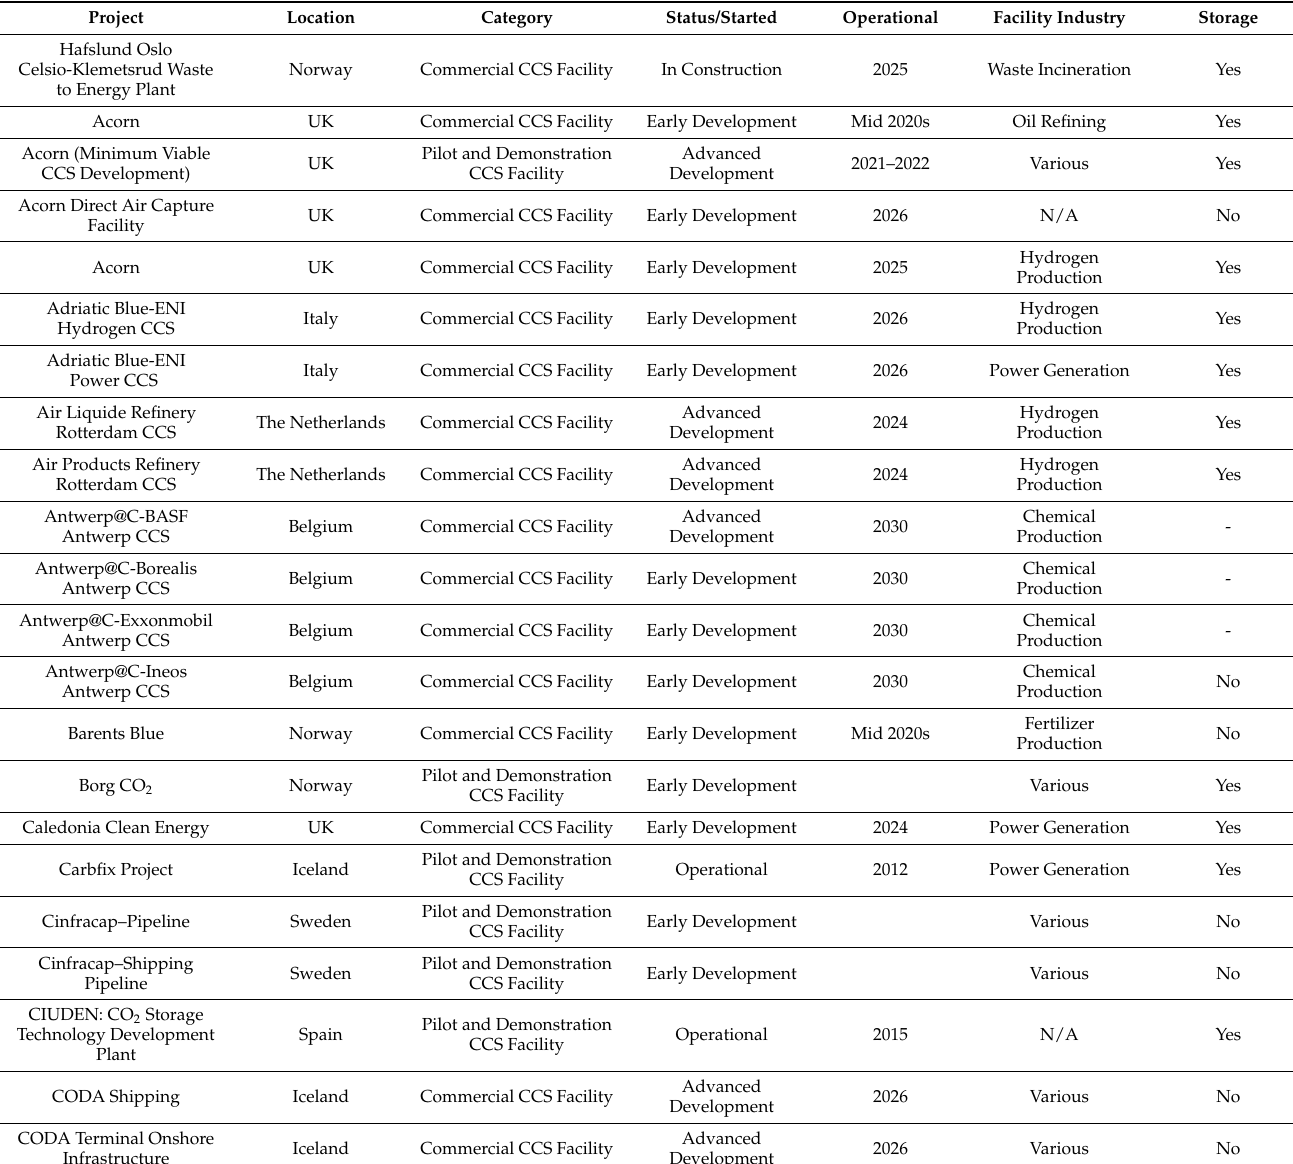
Table 1. Commercial- and Pilot/Demonstration-scale CCS Facilities around Europe. Adapted